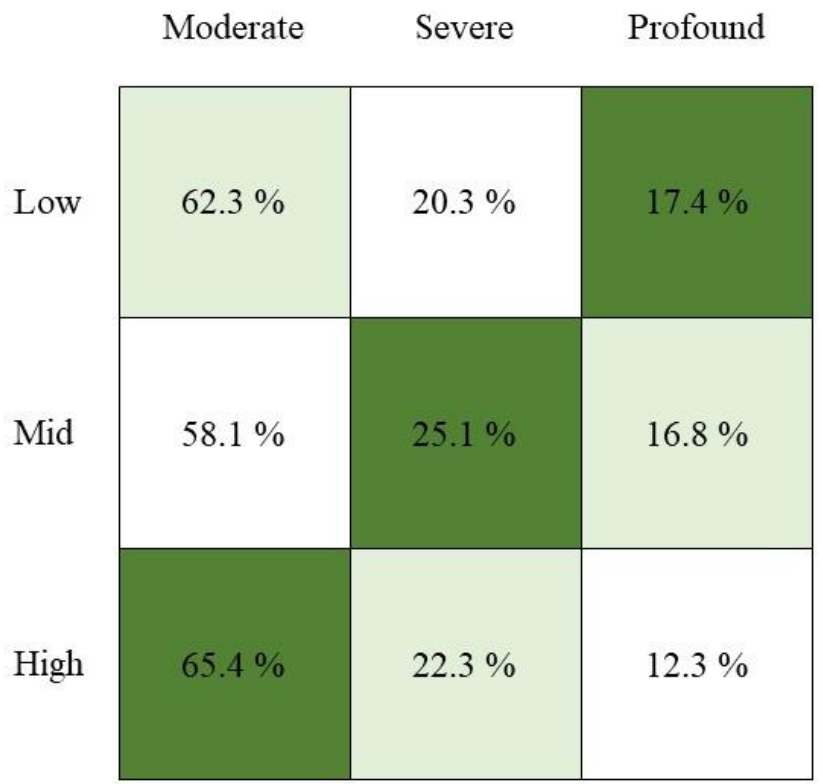
Figure 1. Degree of Hearing Loss in income group ( n =